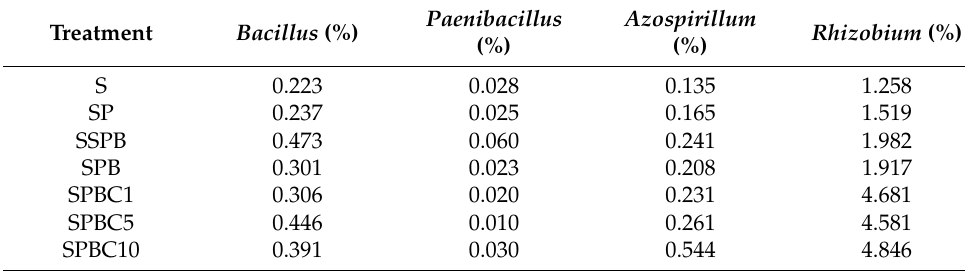
Notes: “S” represents “unsterilized soil”, “SS” represents “sterilized soil”, “P” represents “plant”, “B” represents “functional bacteria”, “C” represents “biochar”, and the number following the abbreviation represents the proportion of biochar mass to soil